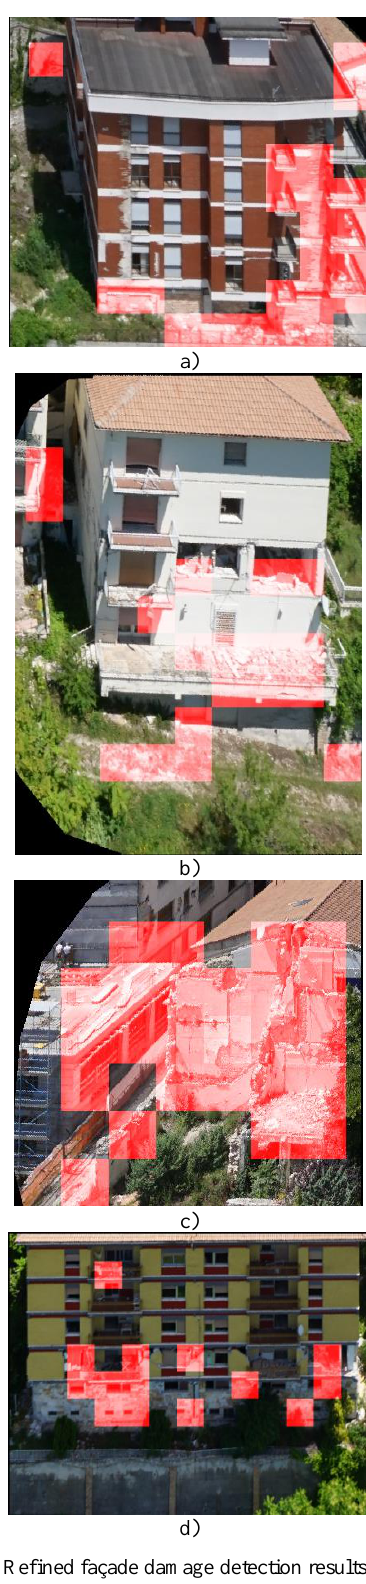
Figure 12 Refined façade damage detection results: a, b, c and d. Damaged patches overlaid in